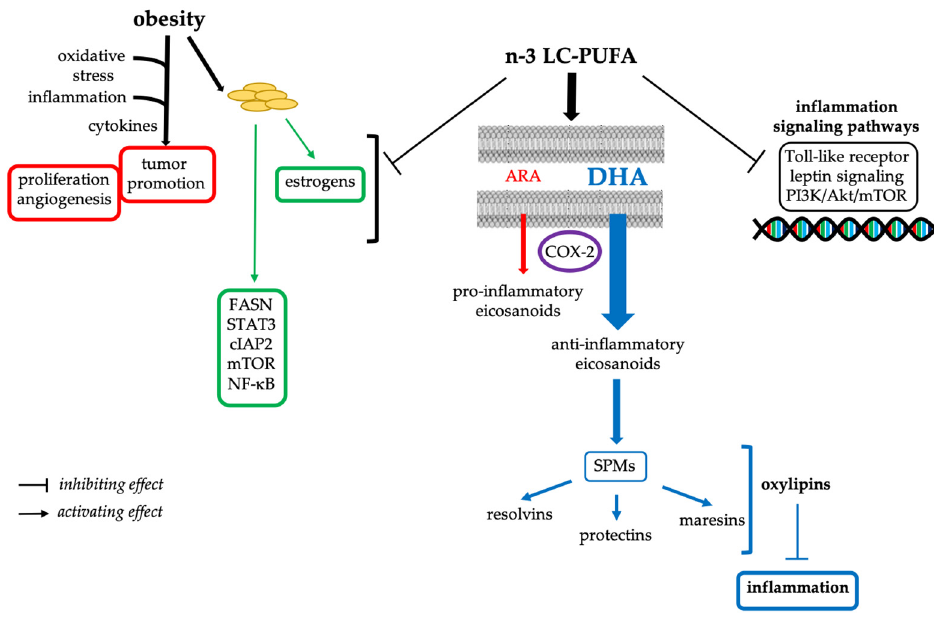
Figure 3. Anti-inflammatory effects of n-3 LC-PUFAs related to obesity and breast cancer.